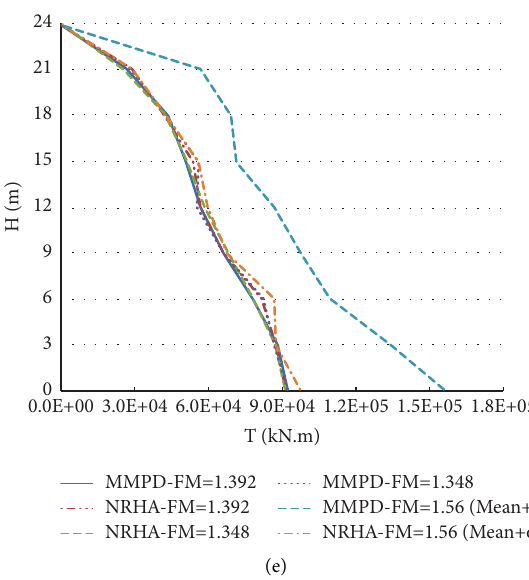
Figure 17: Building B1 under LANDERS record with diferent distributions of reinforcements: (a) comparison between NRHA and interstorey drifts limit, (b) NRHA fexural moment demands and MMPD fexural capacities of 30cm wall, (c) NRHA fexural moment demands and MMPD fexural capacities of 20cm wall, (d) NRHA/approximated MMPD shear demands and (e) NRHA/approximated MMPD torsional